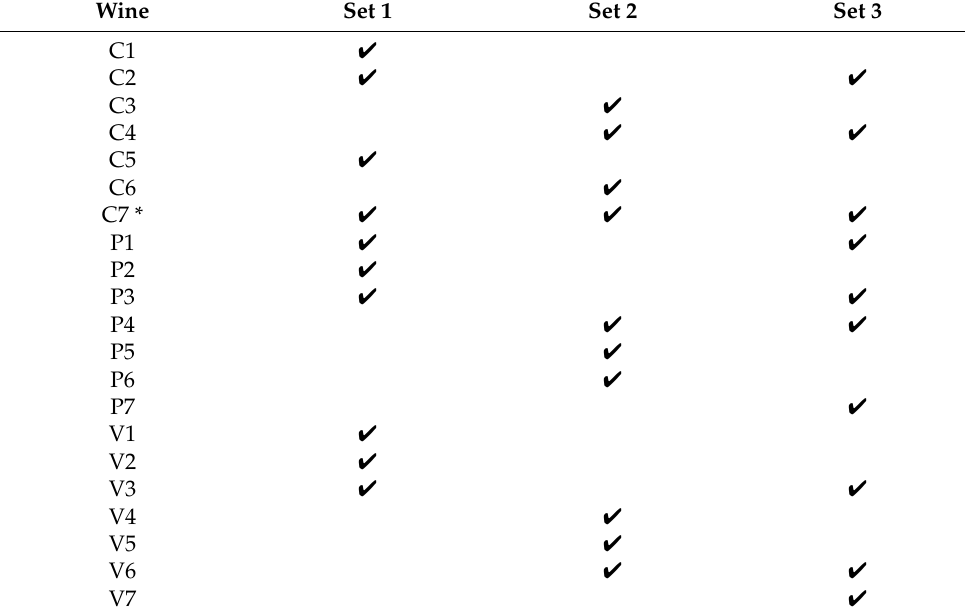
Table 2. Experimental